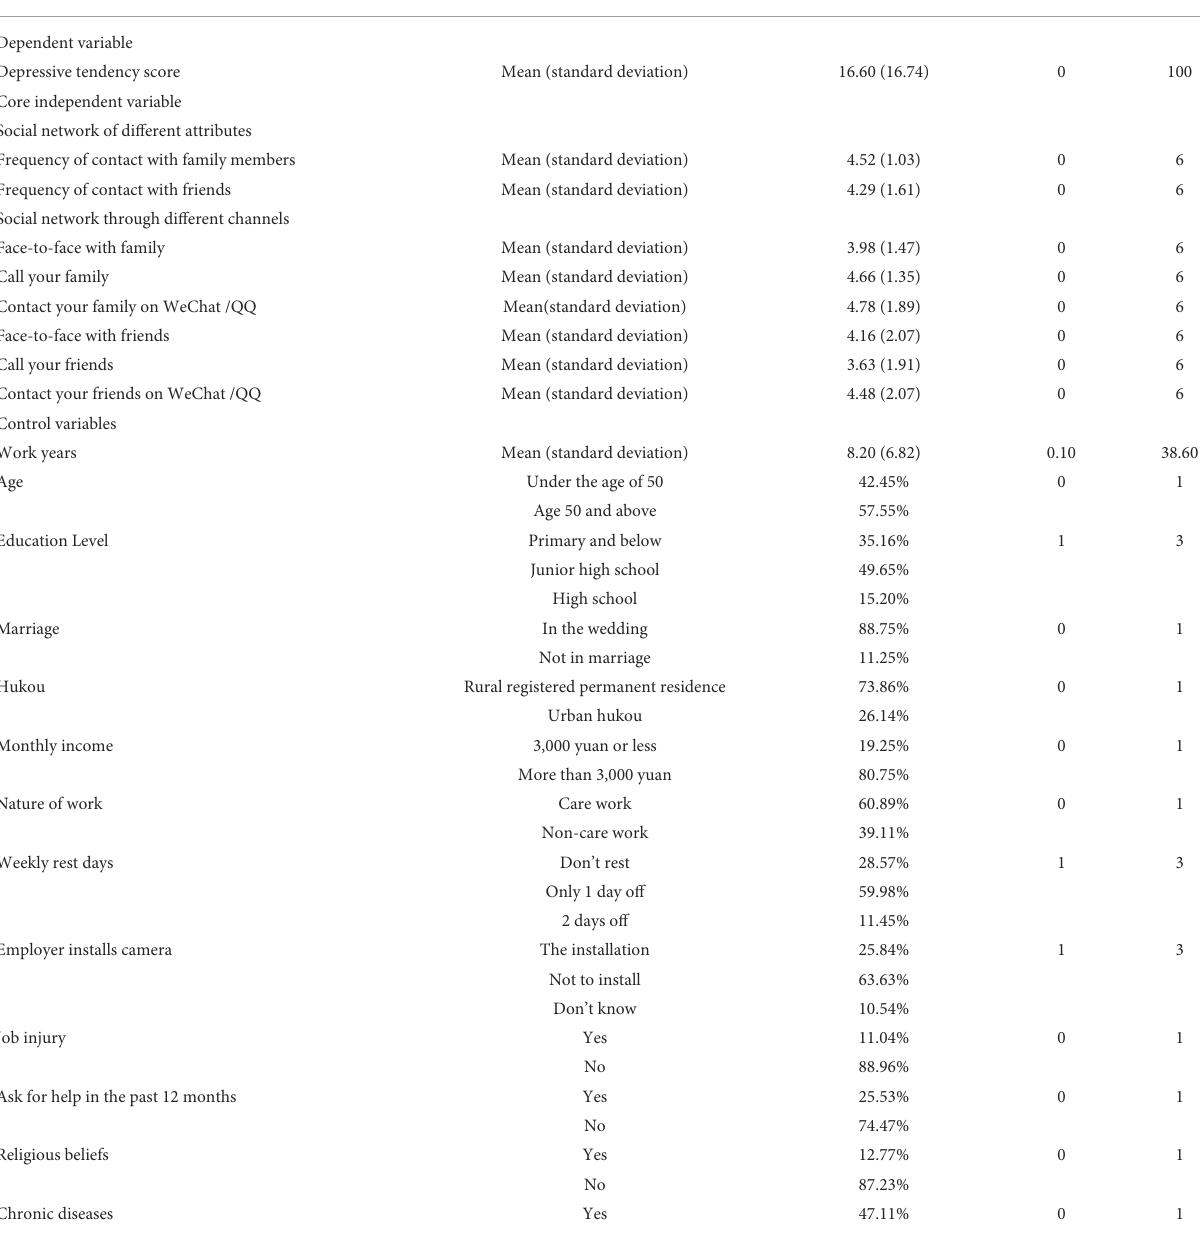
TABLE 1 Description of model variables ( N =